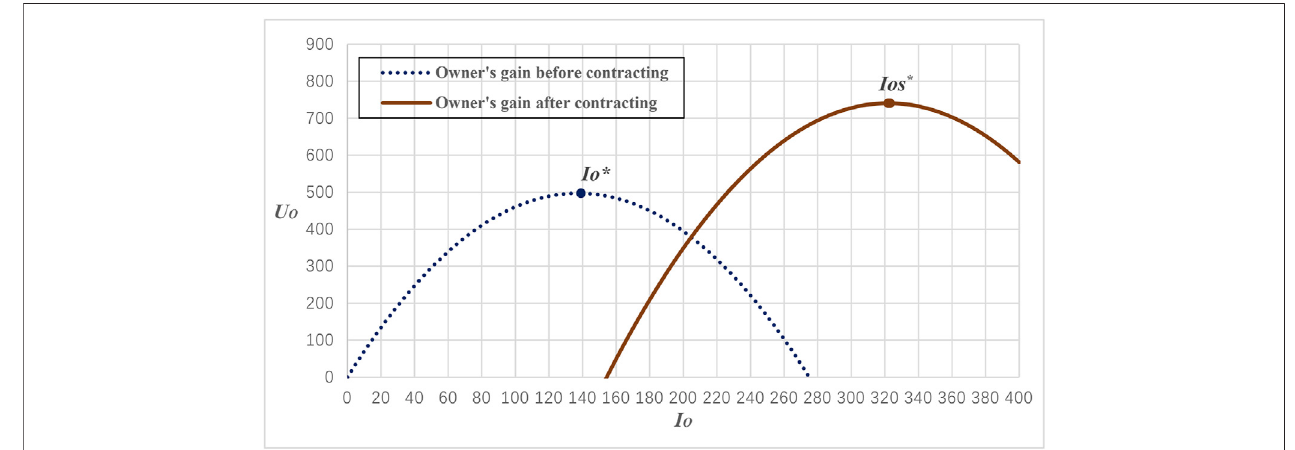
FIGURE 2 | The owner ’ s gain function before and after contracting in Scenario I.